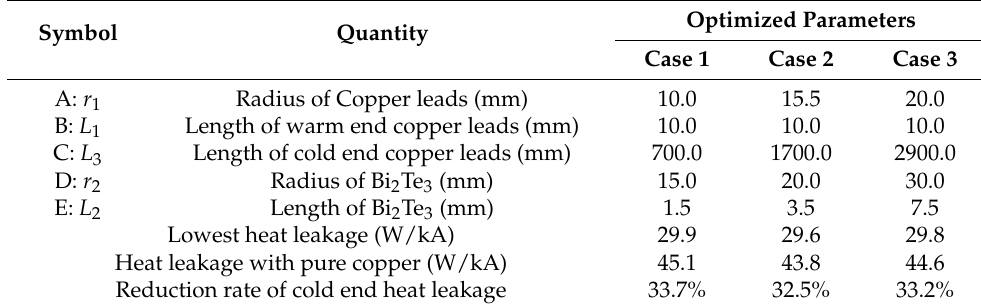
Table 6. Three sets of optimal parameters for 1200 A